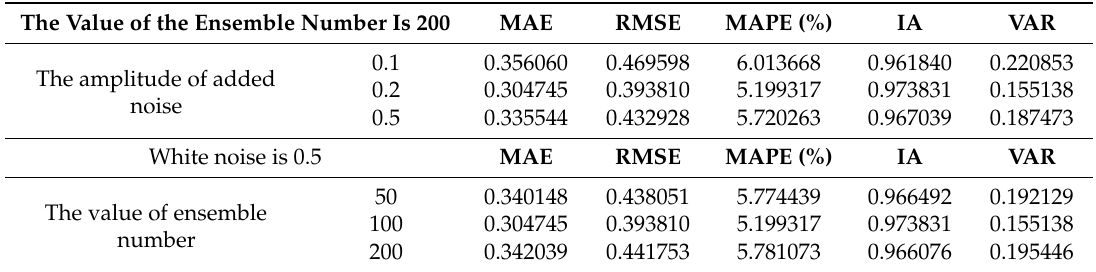
Table 13. Results of sensitivity analysis of parameters in the proposed hybrid forecasting